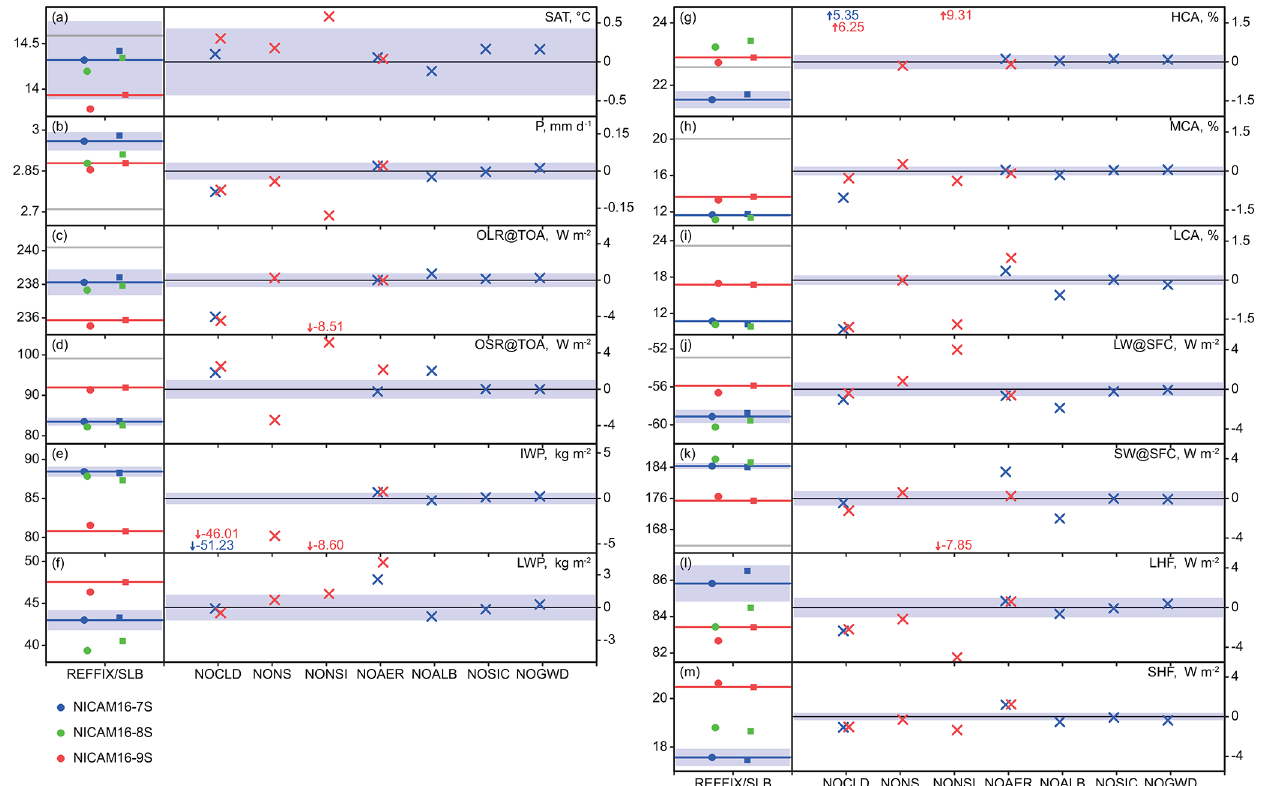
Figure 5. Global annual means of surface air temperature (a) , precipitation (b) , top-of-atmosphere (TOA) outgoing longwave radiation (OLR) (c) , TOA outgoing shortwave radiation (OSR) (d) , ice water path (e) , liquid water path (f) , high cloud amount (g) , middle cloud amount (h) , low cloud amount (i) , surface net downward longwave radiation (j) , surface net downward shortwave radiation (k) , surface latent heat flux (l) , and surface sensible heat flux (m) . The global annual means are averaged over June 2004–May 2005, and their units are shown at the upper-right corner of each panel. Blue shading shows the interannual variability (2 σ , detrended) estimated from the HighResMIP NICAM16-7S run over 1950–2050 (Table 1). The left part of each panel contains plots of global annual means simulated by NICAM16-7S (56km mesh; blue), NICAM16-8S (28km mesh; green), and NICAM16-9S (14km mesh; red), which were performed under the fixed SST condition (filled circles; REFFIX run in Table 2) and with the slab ocean condition (filled squares; REFSLB run in Table 2). Blue and red lines are the reference (REF) runs with 56km mesh and 14km mesh, respectively. Observational values taken from the JRA-55 reanalysis (surface air temperature), GPCP (precipitation), CERES (radiation), and ISCCP (cloud amount) are shown as gray lines. The right part of each panel shows differences between the REF run and each sensitivity run (NOCLD, NONS, NONSI NOAER, NOALB, NOSIC, and NOGWD runs in Table 2). simulated by NICAM16-7S (56km mesh; blue multiplication sign), and NICAM16-9S (14km mesh; red multiplication sign). Results outside the scale range are shown with